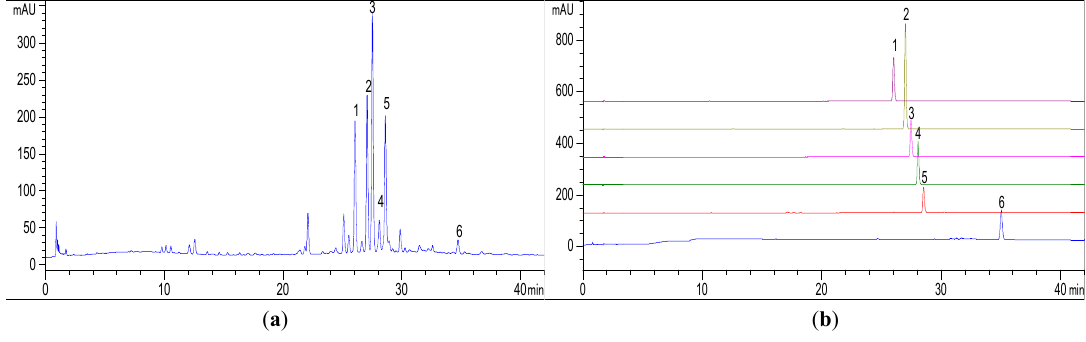
Table 1. 1 H and 13 C NMR data of compounds 1 and 4 (in CDCl 3 ). Position